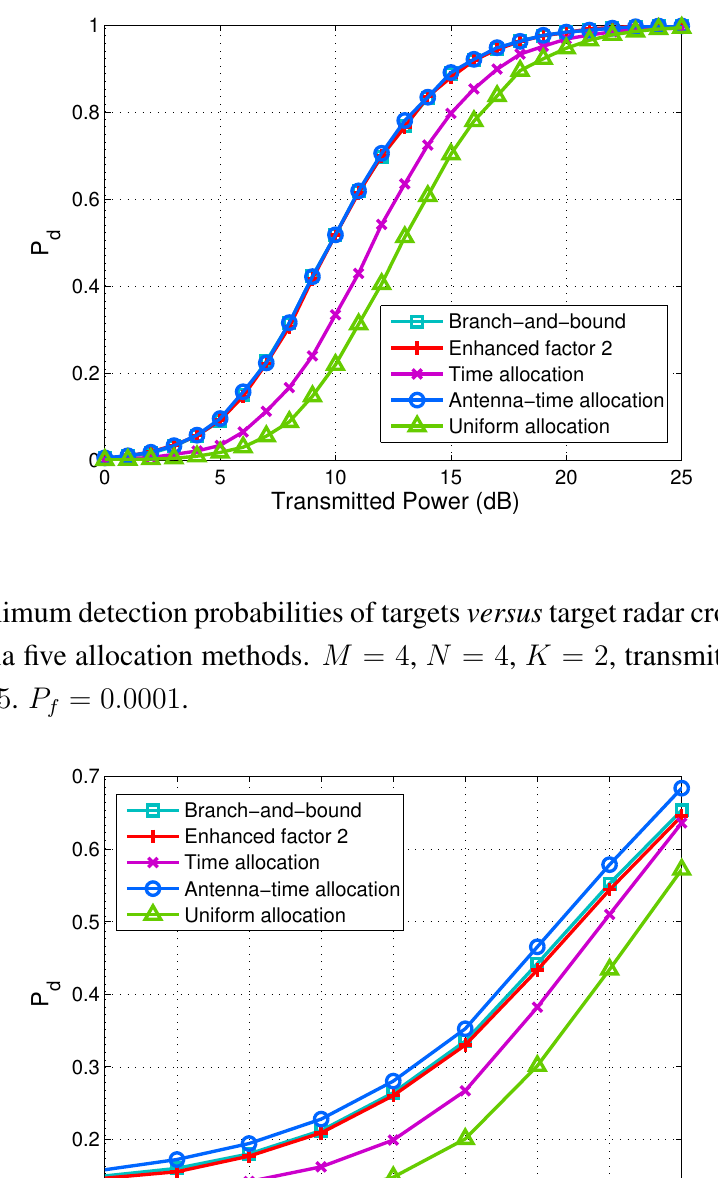
Figure 6. Minimum detection probabilities of targets versus transmitted power via branch-and-bound algorithm, enhanced factor 2 algorithm, time allocation scheme, antenna-time allocation scheme and uniform allocation scheme. M = 4 , N = 4 and K = 2 . R = diag (5 , 0 . 5 , 0 . 2 , 1) , R = diag (0 . 01 , 2 , 1 , 0 . 1) and σ 2 = 5 . P = 0 . 0001 . H, 1 H, 2 f w